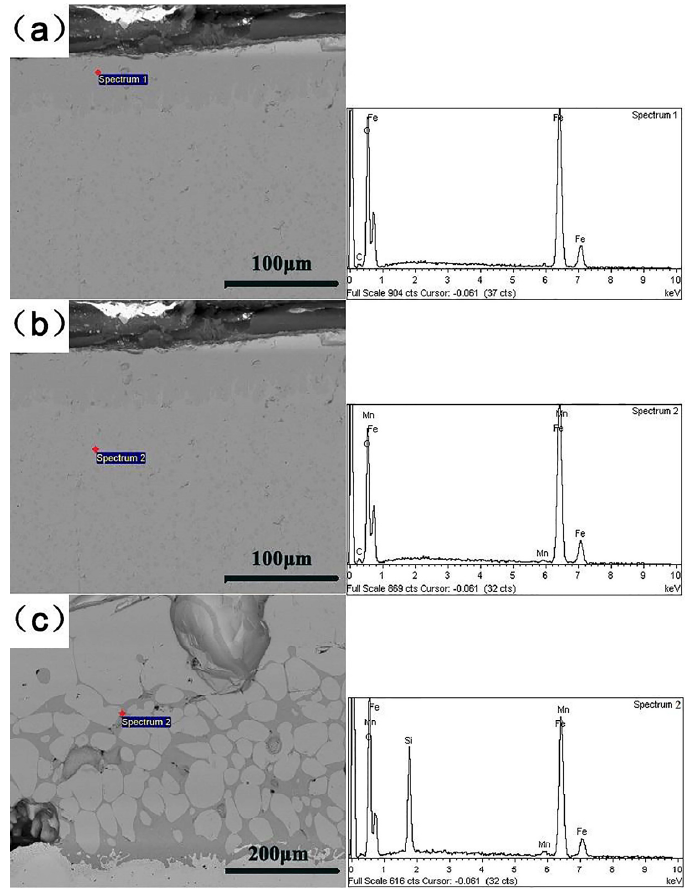
Figure 3. Energy ‐ dispersive spectroscopy (EDS) results of oxide scale for Steel 1. ( a ) Upper layer; ( b ) middle layer; ( c ) inner layer. Table 2. The main atomic percentage of each layer in sample Steel 1 (atom %).